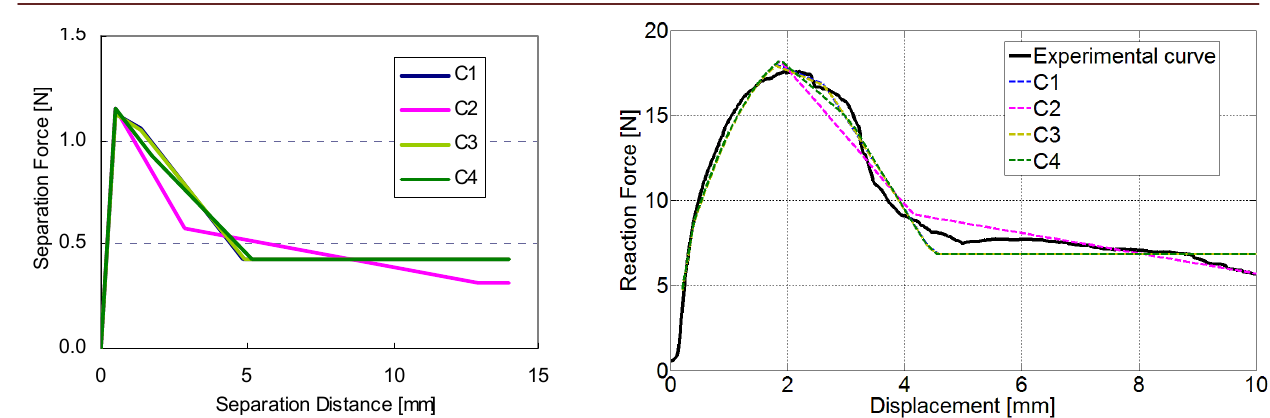
Figure 11: Graphical representation of the identified traction − separation law in the four cases shown in Tab. I (left) and the reconstructed load − displacement curves compared with the experimental output (right); output C2 corresponds to the best matching solution (see Tab. 1).